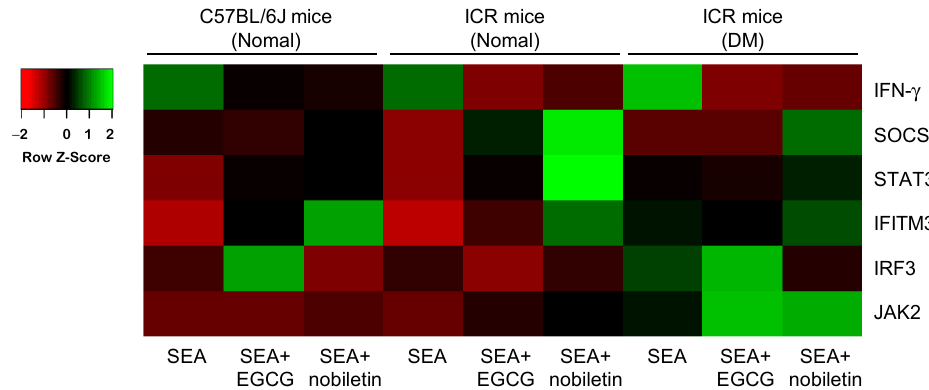
Figure 7. The effect of EGCG and nobiletin on SEA-induced changes in JAK/STAT pathway-related gene expression. Spleen cells from normal mice and diabetic mice (DM) were exposed to SEA, EGCG, and nobiletin. The results for C57BL/6J mice (normal) are shown only for the group treated with EGCG. The fold change was determined relative to the control without SEA treatment. Differential expression of mRNA is shown by the intensity of green (upregulation) versus red (downreg- ulation).